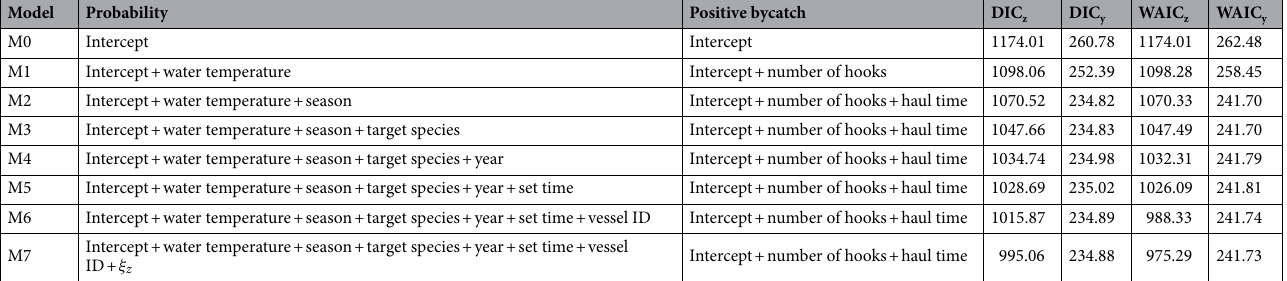
Table 1. Models fitted to data from 11 fishing zones. Abbreviations are as follow: DIC z – the deviance information criterion (DIC) value on the bycatch probability component, DIC y – the DIC value on the positive bycatch component, WAIC z – the Watanabe-Akaike information criterion (WAIC) value on the bycatch probability component, WAIC y – the WAIC value on the positive bycatch component, ξ z and ξ y – constant spatial effect; ξ t z and ξ t y – spatial effect with a different realization every year. Top performing models in each step were listed for brevity.